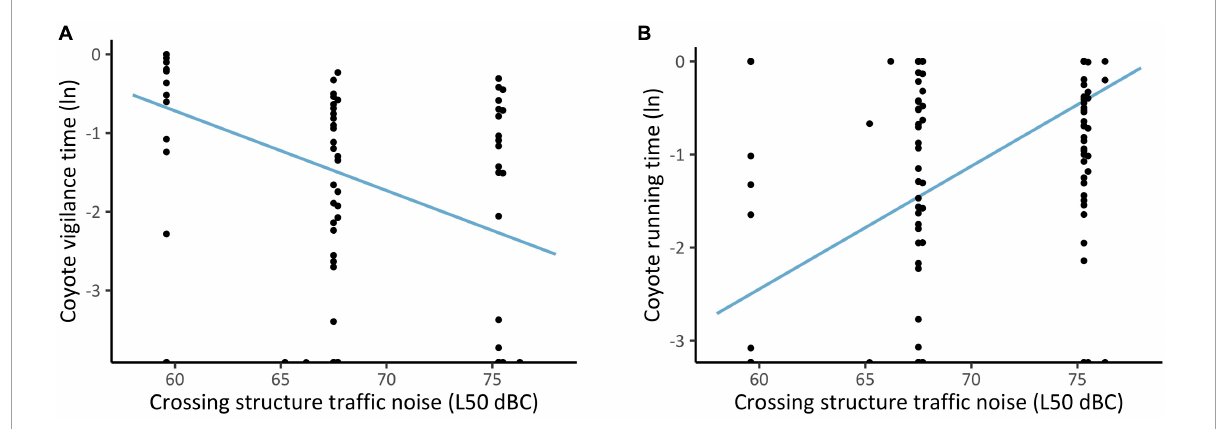
FIGURE5 Proportion of time coyotes spent being (A) vigilant and (B) running at crossing structures with differing chronic (1 week) noise levels (black dots). To capture the estimated effect of chronic noise independent of other covariates, the line of best fit was generated using a predictive model.